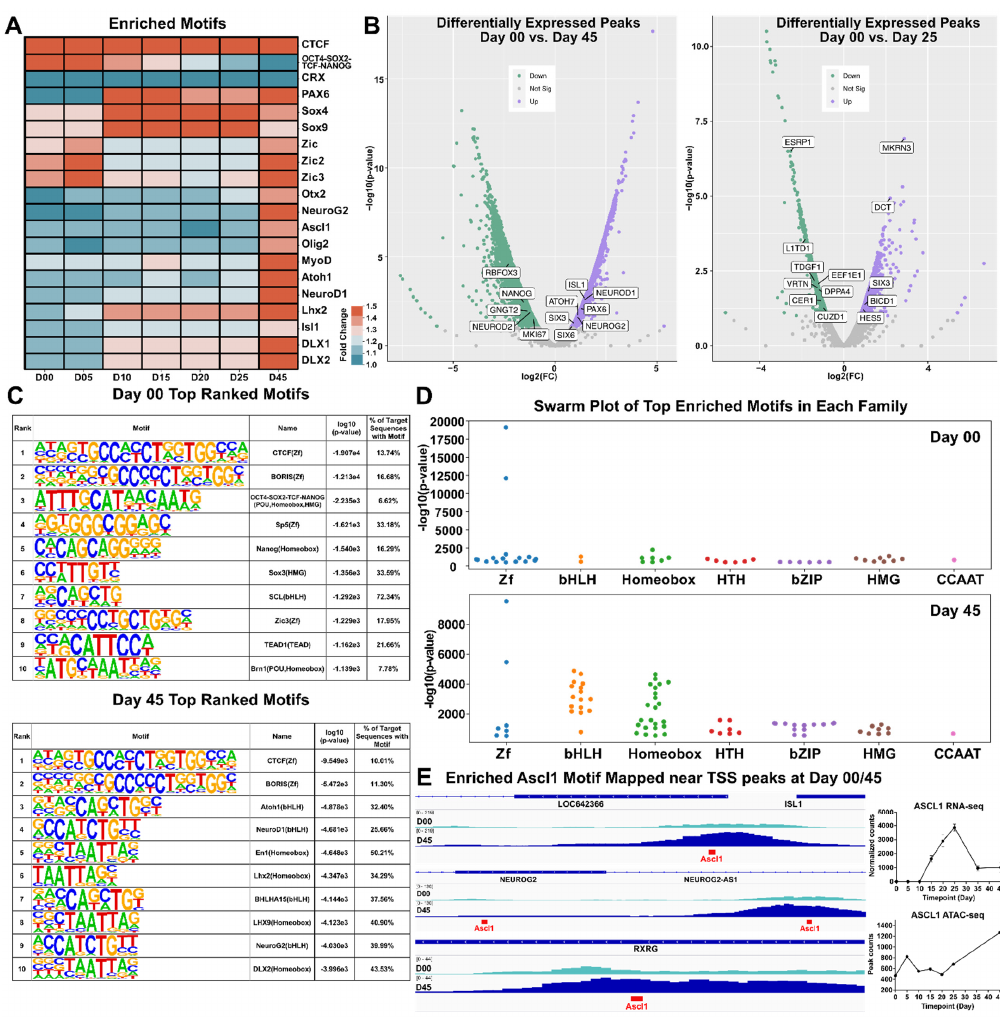
Figure 5. Motif Discovery. ( A ) Heatmap showing the normalized -log10(p-values) of selected significantly enriched motifs detected by HOMER. ( B ) Volcano plots displaying showing differentially expressed peaks from Day 45 with respect to Day 00 (left) and Day 25 with respect to Day 00 (right). ( C ) Tables displaying the top 10 motifs each for Day 00 (top) and Day 45 (bottom), along with their motif name and type and the percentage of target sequences that contained the motif. Motifs were ranked according to –log10(p-values). ( D ) Swarm plots indicating clusters of top enriched motifs in each transcription factor family plotted according to their -log10(p-value) at day 00 (top) and day 45 (bottom). ( E, left ) Genomic tracks showing enrichment of Ascl1 motif (in red) amongst transcriptional start sites (TSS) of ISL1 , NEUROG2 and RXRG at day 00/45. ( E, right ) RNA-seq normalized counts and ATAC-seq peak counts for ASCL1 . Zf = zinc finger; bHLH= basic helix-loop-helix; HTH= helix-turn-helix; HMG = High mobility group; bZIP = basic leucine zipper; CCAAT = CCAAT box.